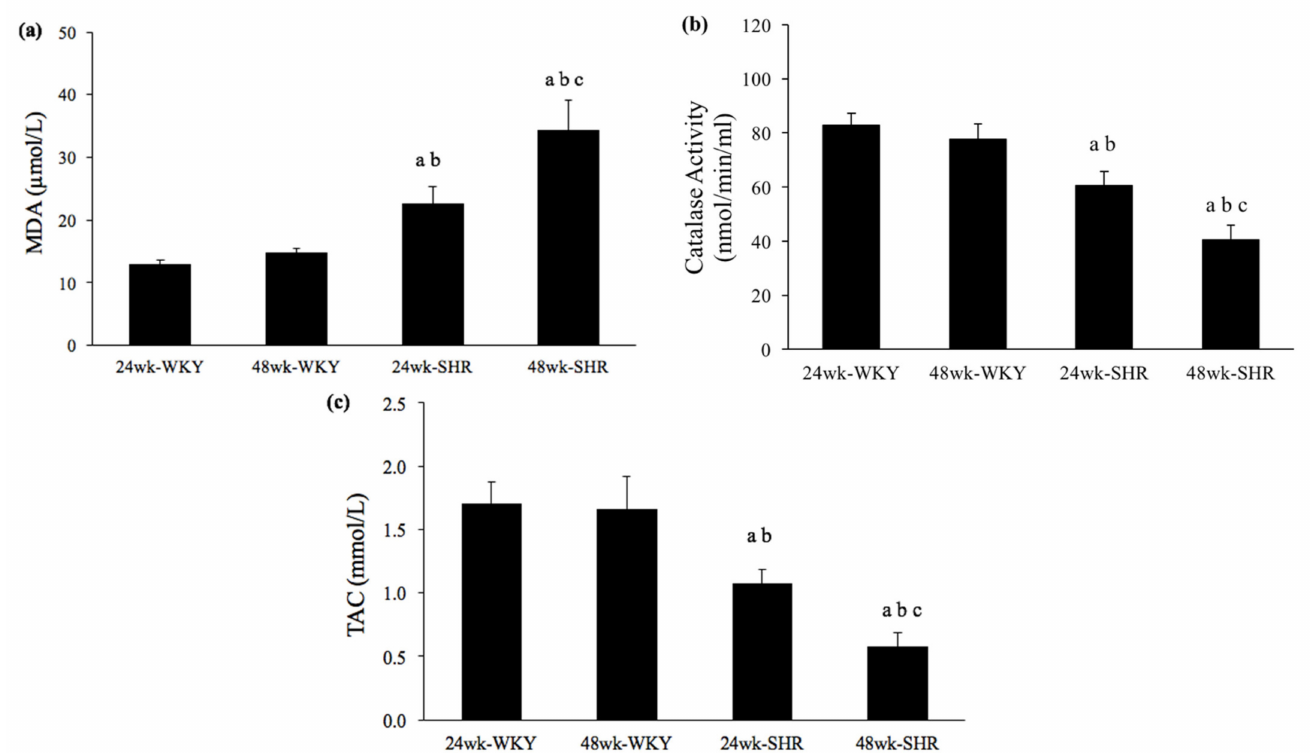
Figure 5. Serum levels of malondialdehyde (MDA), catalase activity, and total antioxidant capacity (TAC). ( a ) Serum MDA concentration, ( b ) catalase activity, and ( c ) TAC in the 24wk-WKY, 48wk-WKY, 24wk-SHR, and 48wk-SHR groups. a p < 0.05, significant differences from 24wk-WKY; b p < 0.05, significant differences from 48wk-WKY; c p < 0.05, significant differences from 24wk-SHR; n = 8 in each